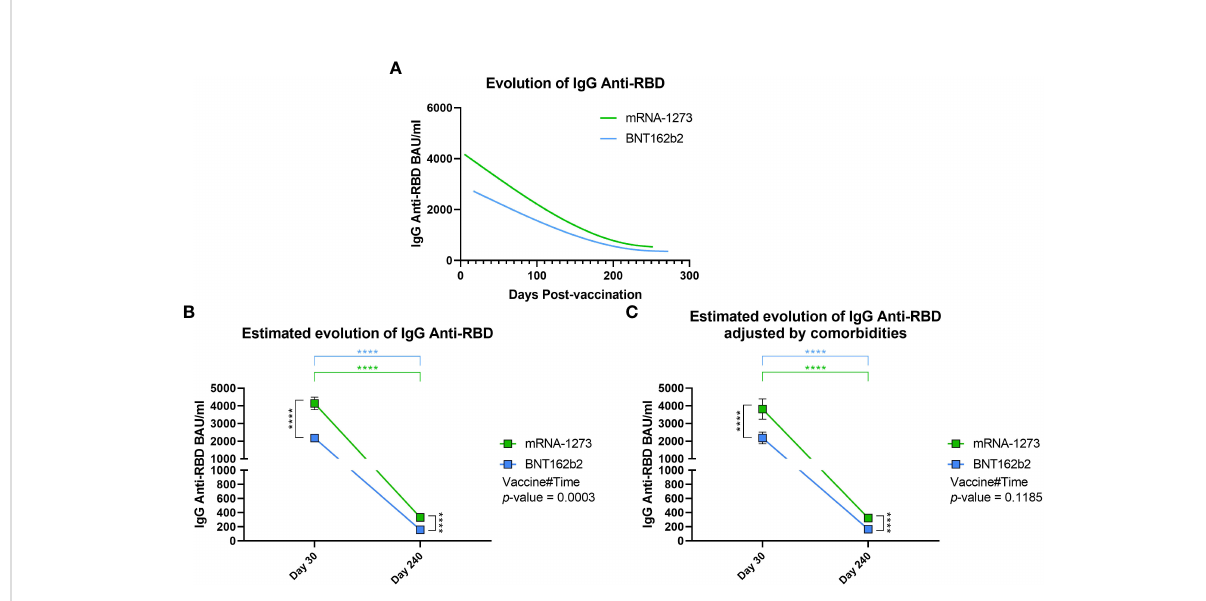
FIGURE 4 Evolution of IgG Anti-RBD levels during follow-up. (A) Spline representation of the evolution of IgG anti-RBD levels in both mRNA-1273- and BNT162b2-vaccinated individuals. For each individual, the exact day post-vaccination was selected. The spline representation was made by smoothing the spline with three knots. (B) Estimated evolution of IgG anti-RBD levels for both vaccines adjusted by age and gender, calculated using a mixed-effects model with transformed logarithmic IgG anti-RBD values and with tobit regression. Vaccine#Time indicates the behaviour of each vaccine during the follow-up. Squares indicate the estimated mean, and brackets indicate a 95% con fi dence interval. (C) In the randomized cohort, the estimated evolution of IgG anti-RBD levels for both vaccines was adjusted by age, gender, and comorbidities in a multivariable analysis. **** p -value <